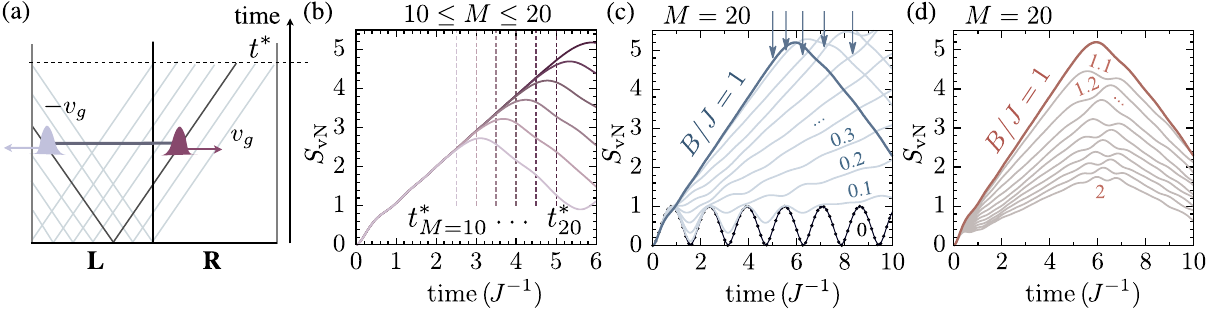
FIG. 2. Entanglement growth after a quantum quench in the transverse Ising model in which nearest-neighbor interactions are introduced suddenly. (a) Illustration of entanglement distribution, via entangled quasiparticle pair excitations that move within a Lieb- Robinson light cone. Boundary effects for this system with open boundary conditions stop the linear increase at a critical time t (cid:6) . (b–d) Time evolution of half-chain entropies for M ¼ 10 , 12, 14, 16, 18, and 20 spins (ED calculation). (b) Boundary effects as a breakdown of the linear growth. Respective critical times calculated for the free fermion model are shown as vertical lines. (c) The crossover from the oscillatory behavior for B ¼ 0 (dots: analytical result) to a linear increase ( M ¼ 20 ). With decreasing B , boundary effects shift to later times; critical times are indicated as vertical arrows. (d) The half-chain entropy growth, which is fastest for B ¼ 1 and decreases again for B > 1 ( M ¼ 20